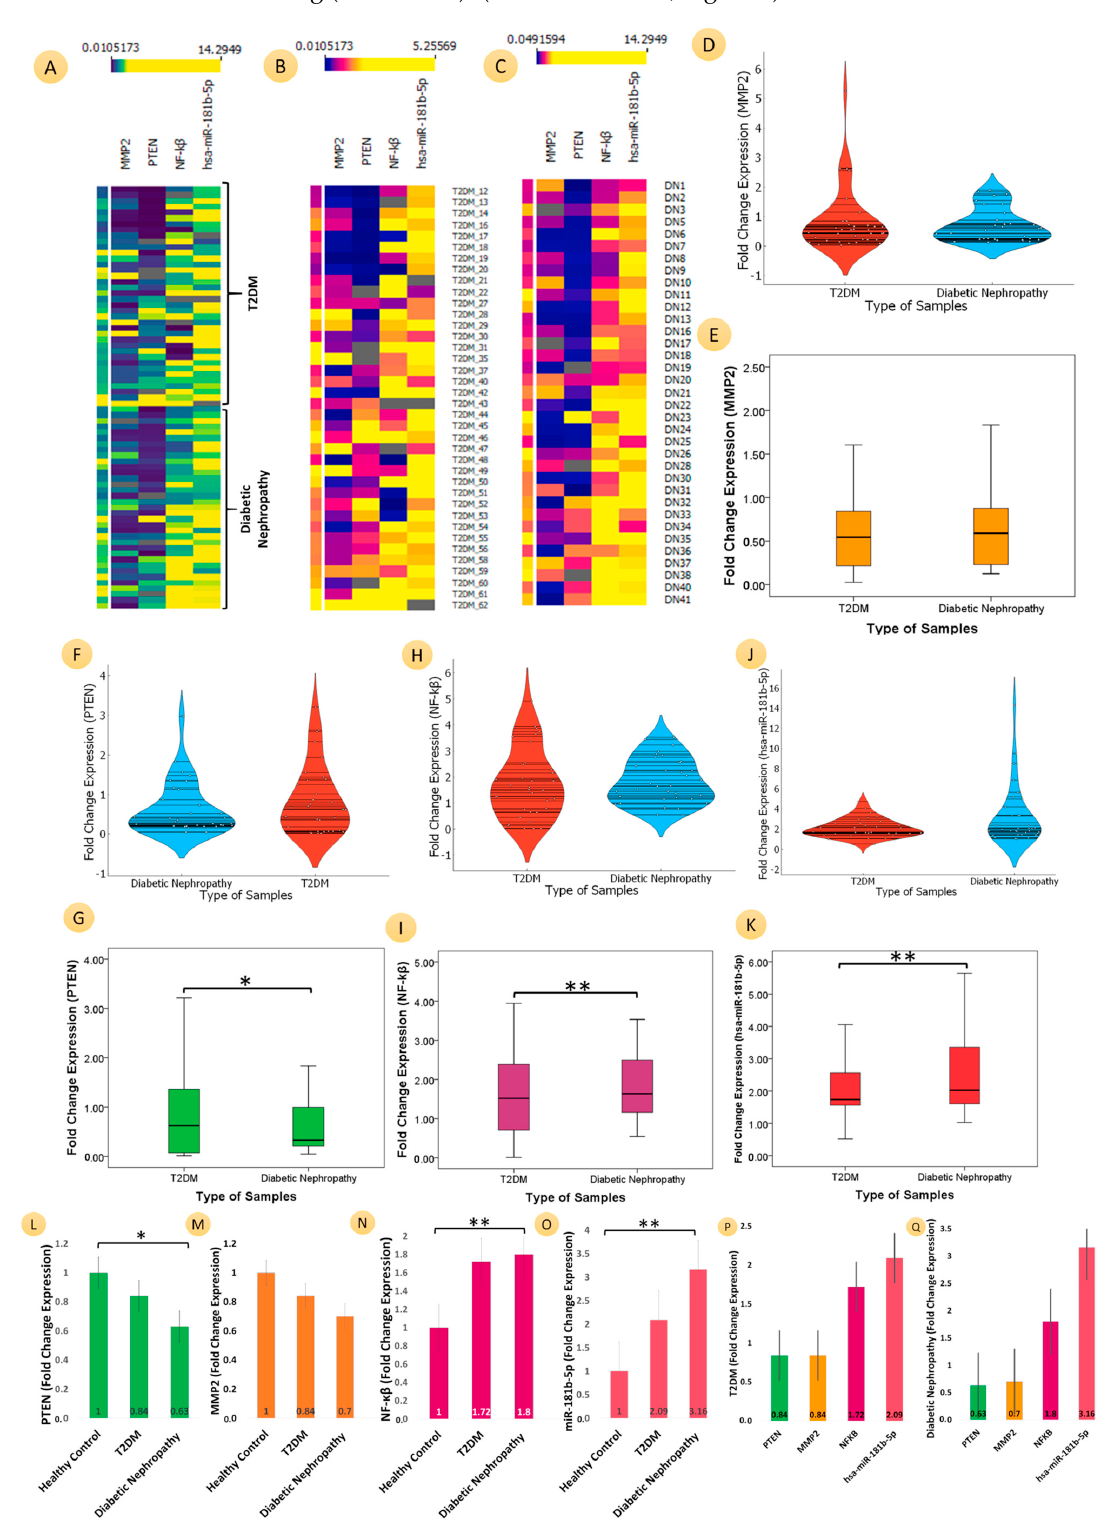
Figure 2. Comparative analyses of the mRNA expression of three genes (PTEN, MMP2, and NF- κ B) and microRNA-181b-5p for T2DM patients, diabetic nephropathy patients, and healthy controls. Heat map ( A ) for both T2DM and diabetic nephropathy samples ( B ) for T2DM samples ( C ) for diabetic